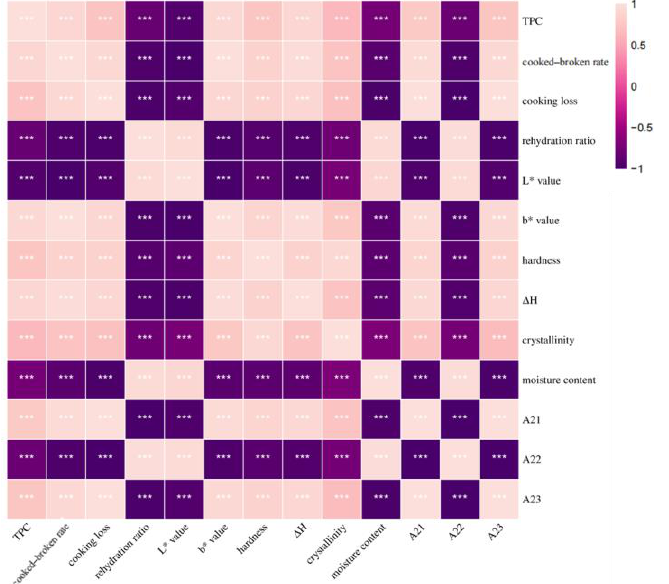
Figure 5. Correlation analysis of various indicators of semi-dried rice noodles during storage. Pearson’s correlation analyses were performed. *** p < 0.001.